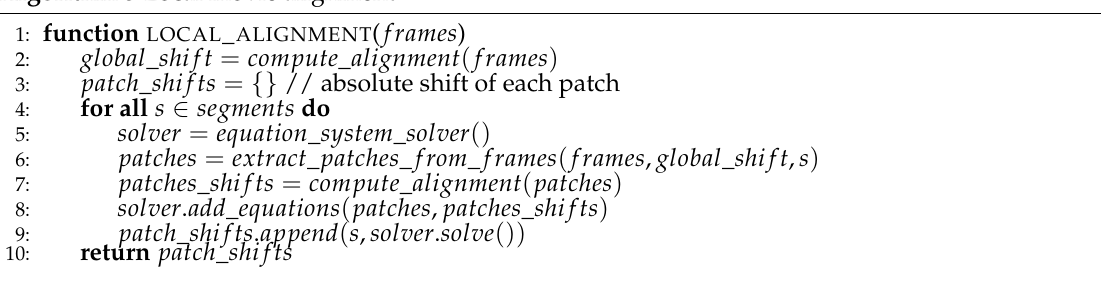
Algorithm 5 Local movie